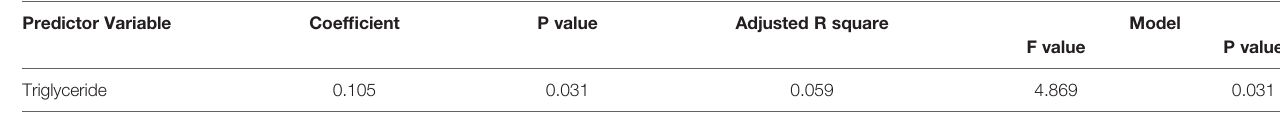
TABLE 5 | Multiple Regression using Stepwise method for Kisspeptin as a dependent variable for PCOS Obese.